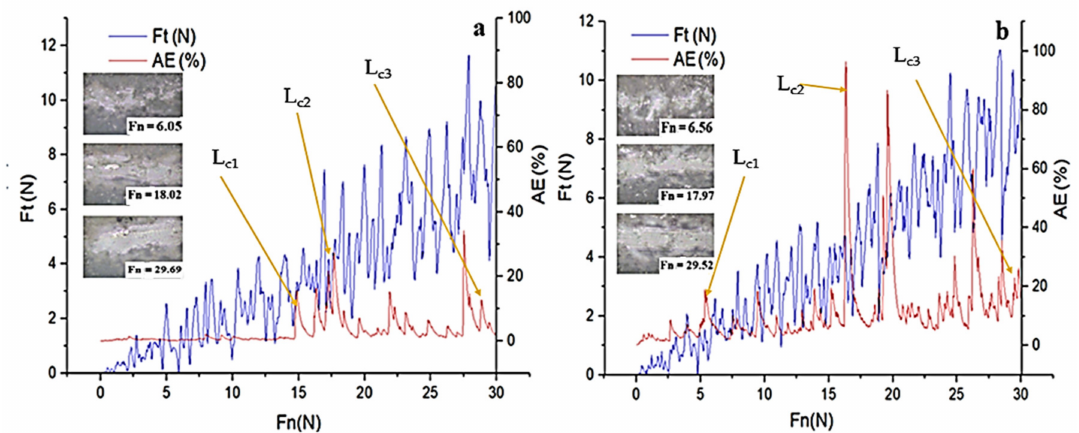
Figure 9. Scratch test results of the A90-P0 ( a ) and A80-P10 ( b )